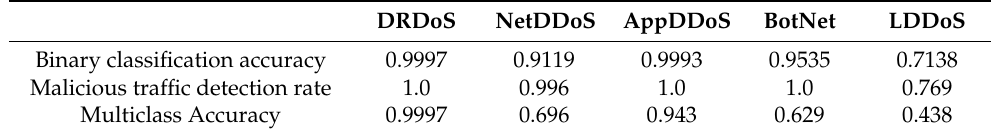
Table 7. The detection results of each module.